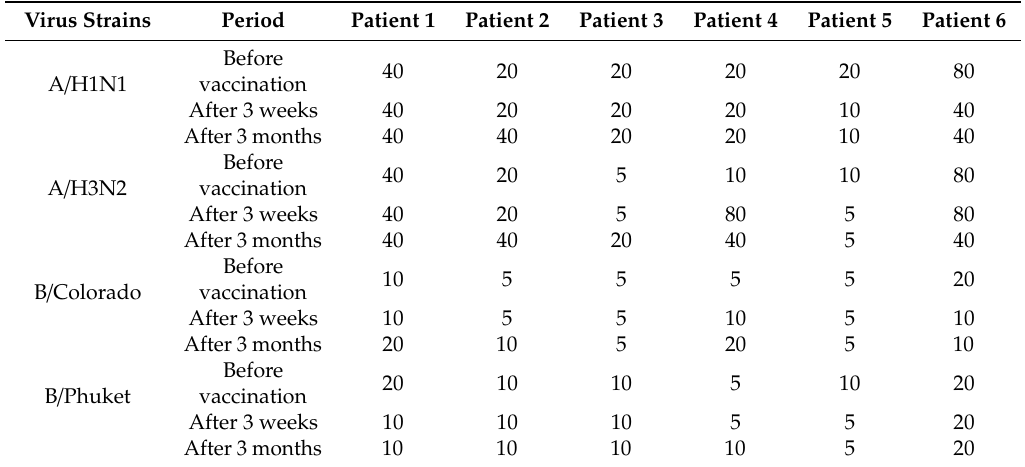
Table 5. Seroprotection level in the group of patients with common variable immunodeficiency (CVID) vaccinated with adjuvant QIV